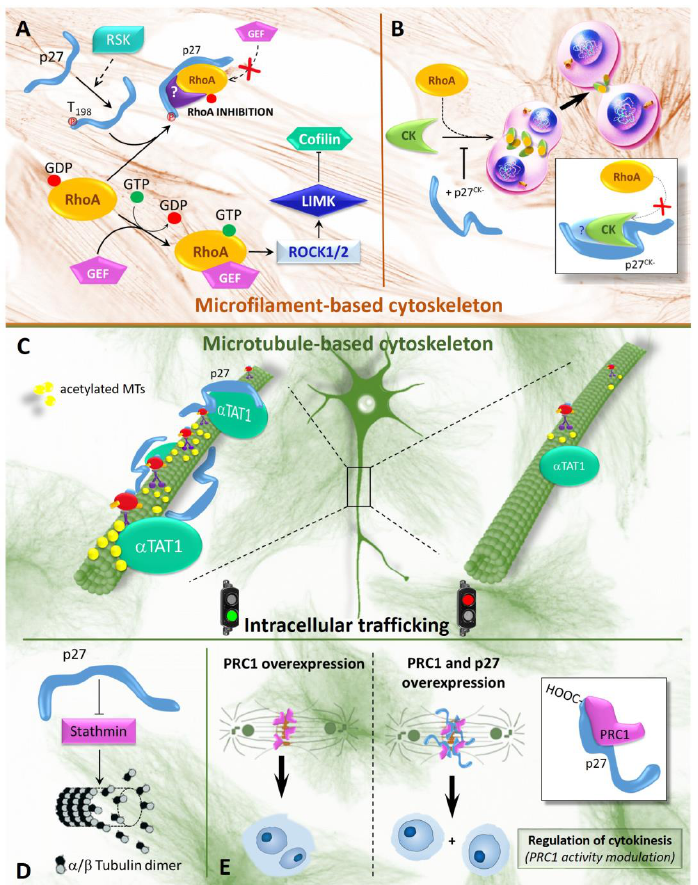
Figure 2. p27 and cytoskeleton remodeling. ( A ). In the cytoplasm, the monomeric G-protein RhoA bound to GDP is in an inactive state. Activation occurs through GDP-GTP exchange by a GEF (guanine nucleotide exchange factor). RhoA-GTP activates ROCK1/2, a kinase able to phosphorylate LIMK that subsequently phosphorylates and inactivates cofilin, a protein severing actin filaments. Therefore, Rho-A activation stimulates phosphorylation of cofilin and stabilizes the actin cytoskeleton. When phosphorylated by RSK1 (p90 ribosomal S6 kinase 1) on T198, p27 is mislocalized in the cytoplasm and is able to prevent RhoA activation by a still not clarified mechanism that could involve p115-GEF functional inactivation. Note that p27 region(s) involved in this activity are not definitely identified. RhoA inactivation results in full activity of cofilin and contributes to the loss of F-actin fibers and increased cell motility. ( B ). A further role of p27 during mitosis is independent of CDK control. p27 and p27CK − (a mutant form of p27 unable to bind Cyclin-CDKs), when not T198- phosphorylated, are able to bind Citron Kinase (CK), preventing the interaction with its activators Rho. Citron Kinase is a serine/threonine kinase and is a Rho effector, with structural homology to ROCK, required in the ingression of the furrow cleavage (and midbody formation) for proper cellular abscission at the end of cytokinesis. p27CK − , competing with Rho for Citron K binding, mainly delay cytokinesis and also caused an increased reopening of the intercellular bridge at the end of cytokinesis, determining multinucleation. ( C – E ) This series of panels shows p27 and MT-dependent intracellular